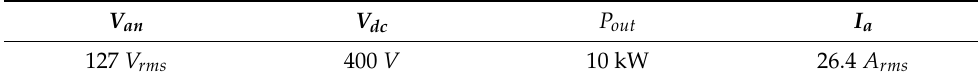
Figure 2. Hybrid AC-DC-AC converter used as the subject of case studies for the software developed in this article. Table 1. Design parameters.